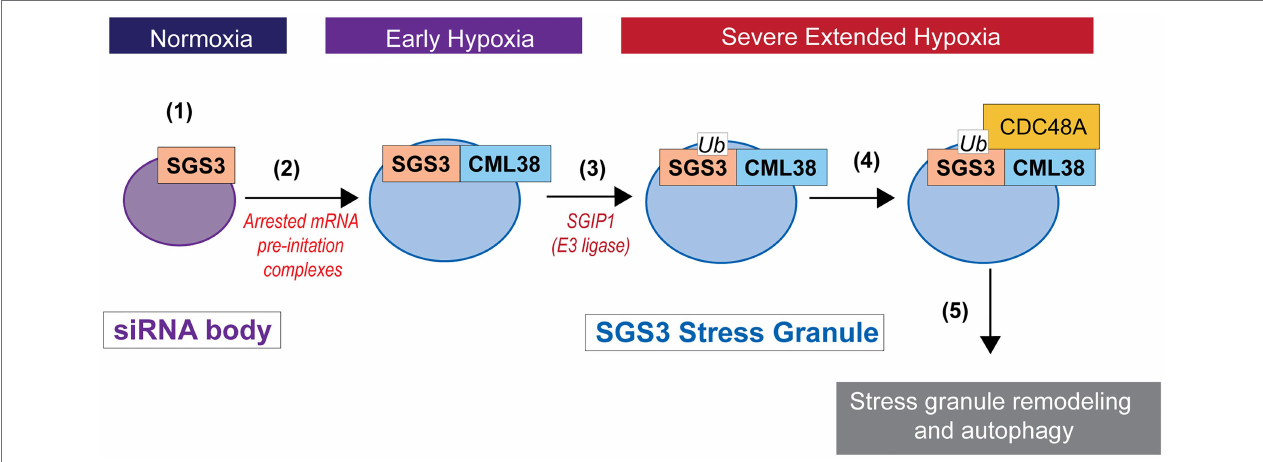
FIGURE 9 | Working model for SGS3 granule regulation by CML38. (1) SGS3 phase separates and localizes to cytosolic siRNA bodies under normoxic conditions. (2) Hypoxia stress results in a low energy state that triggers translational arrest and the concomitant accumulation of mRNA into stress granules that proliferate under this stress. SGS3 accumulates within stress granules. The core-hypoxia response protein CML38 is induced and localizes to SGS3-associated stress granules where it directly interacts with SGS3. (3) The cell experiences carbon starvation during severe extended hypoxia stress that leads to the induction of autophagy. SGS3 is tagged for autophagy degradation by conjugation to ubiquitin catalyzed by an E3 ubiquitin ligase similar to SGS3 INTERACTING PROTEIN 1 (SGIP1; Liu et al., 2019). (4) CML38 recruits CDC48A to stress granules. CDC48A remodels ubiquitinylated proteins within the stress granule, including ubiquitin- tagged SGS3. (5) Stress granule protein complexes remodeled by CDC48A are targeted for autophagic